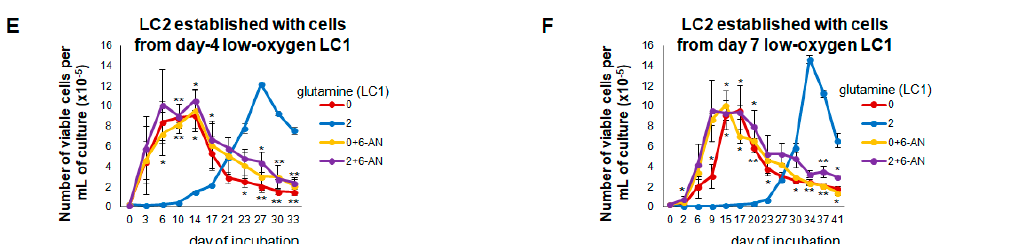
Figure 5. Effects of 3PO or 6-AN on BCR/Abl signaling and maintenance of stem cell potential in low oxygen in the absence or the presence of glutamine. K562 ( A , C , E ) or KCL22 ( B , D , F ) cells were seeded at 3 × 10 5 cells/mL and incubated in atmosphere at 0.2% O 2 for 4 or 7 days, respectively, in the absence (0) or the presence (2) of 2 mM glutamine and with or without ( − /+) the indicated compounds, added at time 0 of incubation (LC1). ( A , B ) Total cell lysates in Laemmli buffer were subjected to SDS-PAGE and immuno-blotting with anti-p-Crkl Ab or anti-vinculin Ab, used to verify equalization of protein loading. One representative experiment out of 3 with similar results is shown. ( C – F ) LC1 cells were replated at 3 × 10 4 cells/mL into drug-free LC2 incubated at 21% O 2 and in any case in the presence of glutamine. Trypan blue-negative cells were counted at the times of incubation in LC2 indicated in abscissa. Values are mean ± S.D. of data obtained from 3 independent experiments; * p < 0.05, ** p < 0.01 vs. 2 mM glutamine/no drug. The original Western blotting images and the relative densitometry values can be found in Supplementary Figure S3.